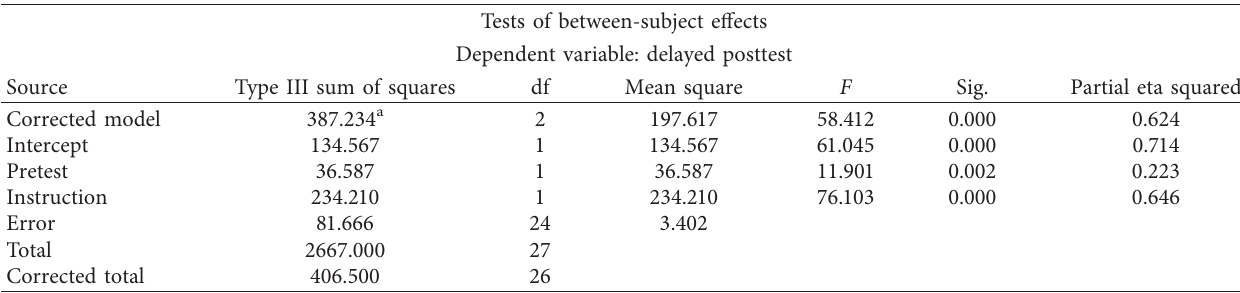
Table 8: Inferential statistic for comparing the post- and delayed posttest scores of online peer feedback and non-peer-feedback.